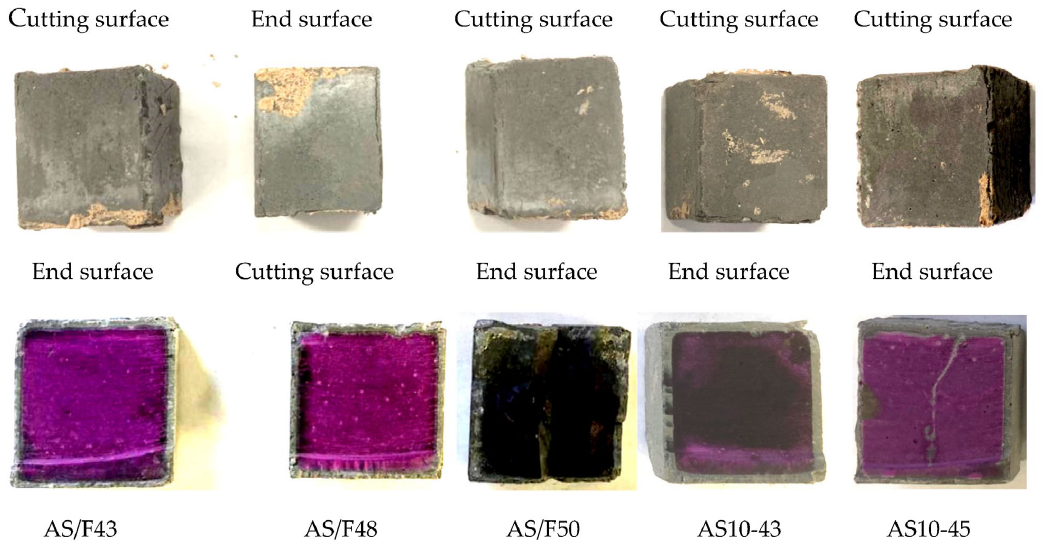
Figure 5. Appearance (upper row) and coloring (lower row) of the specimens with different AS/F after 84 - day immersion.